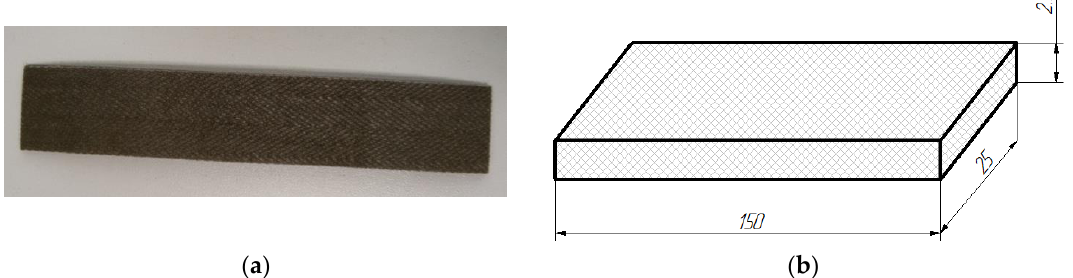
Figure 3. Test samples: ( a ) view of a real sample; ( b ) shape and dimensions of a sample (in mm).